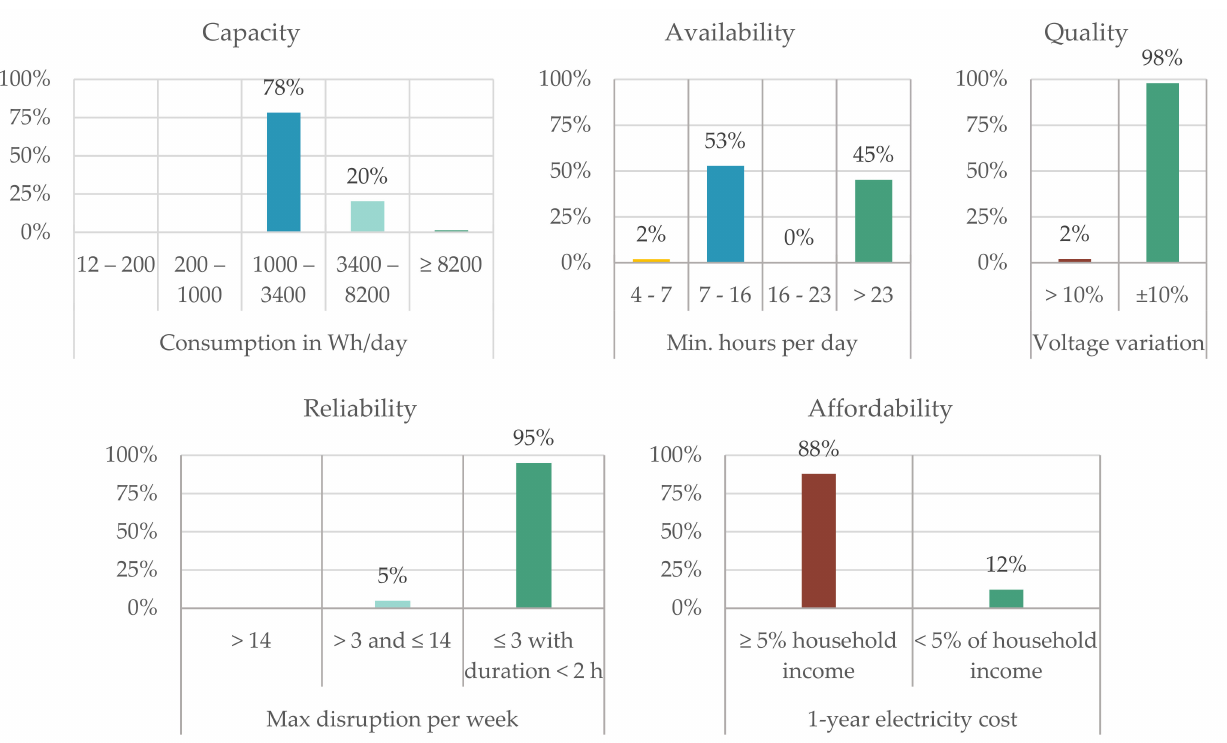
Figure 3. MTF of energy access in Maluku and North Maluku,